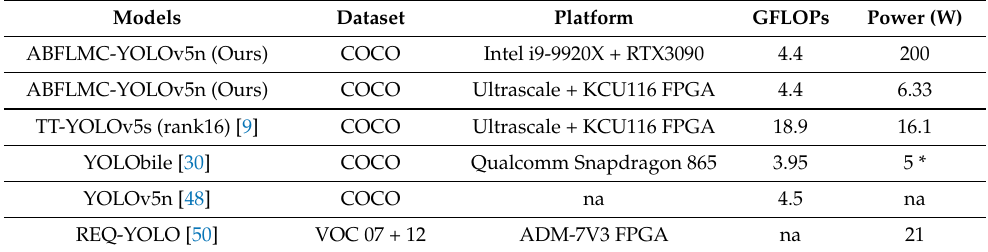
Table 4. Hardware Comparison in different platforms within COCO